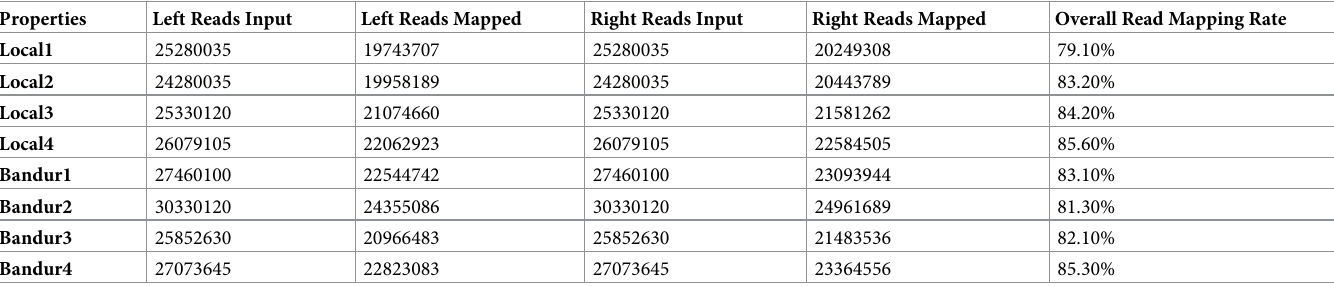
Table 2. Statistics of read mapping to Reference Assembly Oar